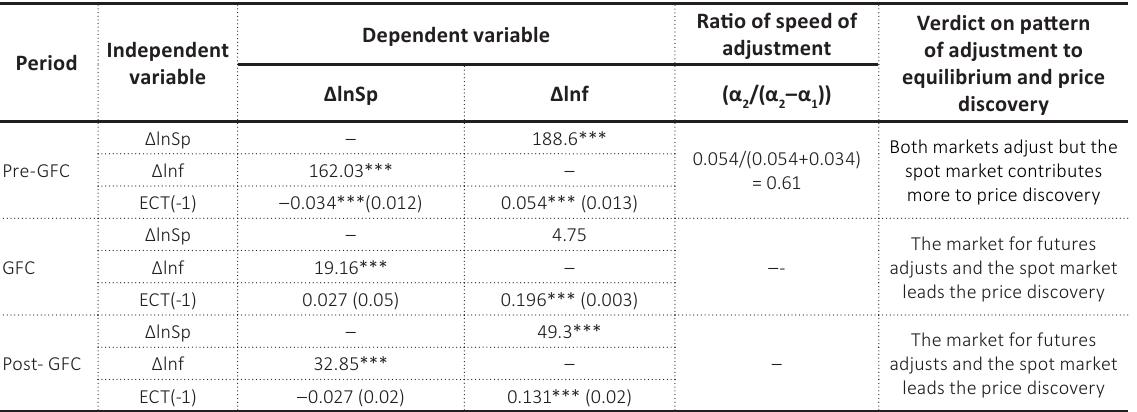
Table 4. VECM results for